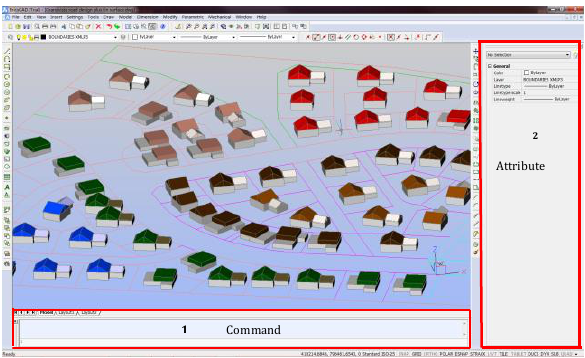
Figure 3. The proposed development in CAD